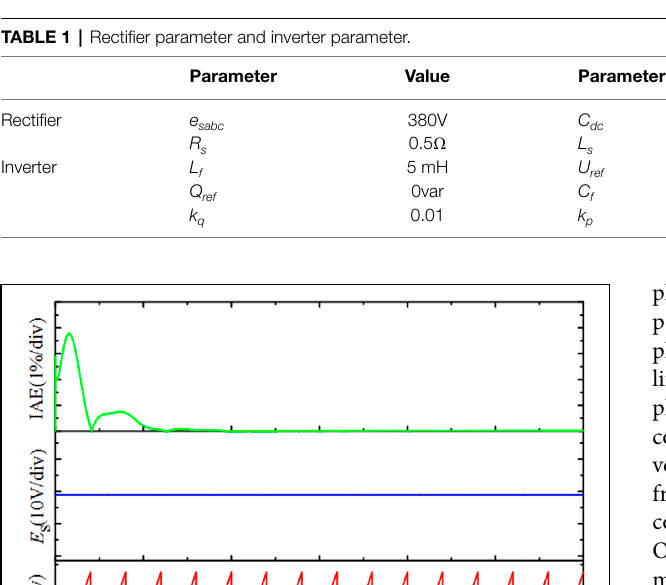
TABLE 1 | Rectifier parameter and inverter parameter.